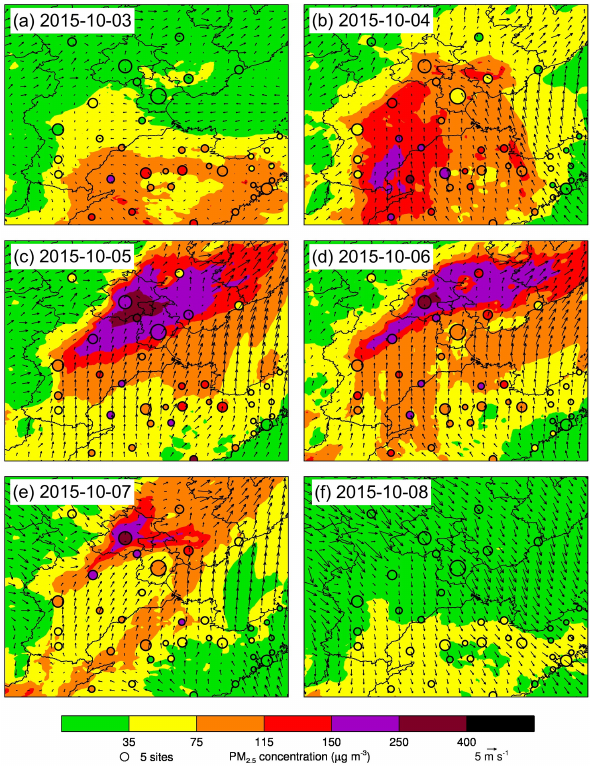
Figure 6. Spatial distributions of the modeled (colored shadings) and observed (colored dots) surface daily PM 2 . 5 concentration from 3 to 8 October 2015. Black arrows show the simulated surface winds.